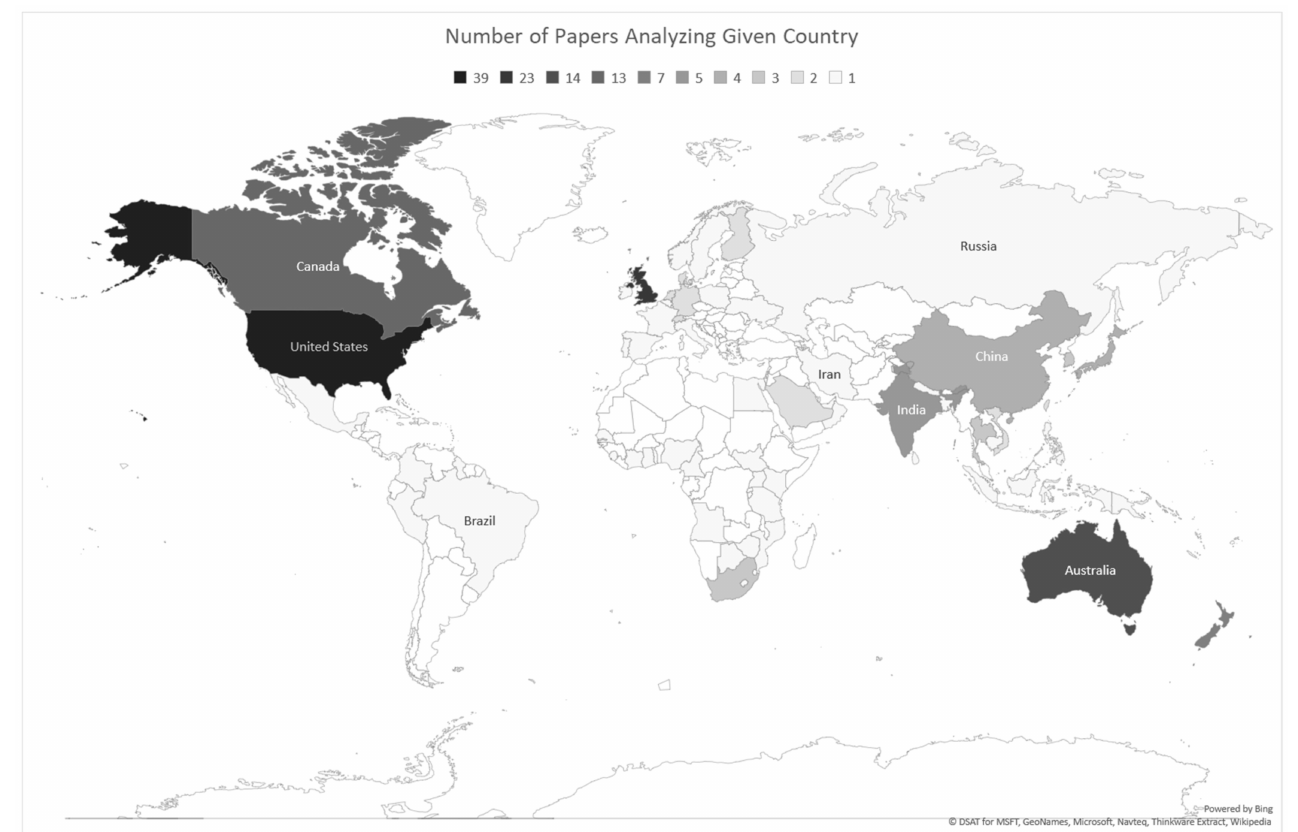
Figure 2. Countries included within